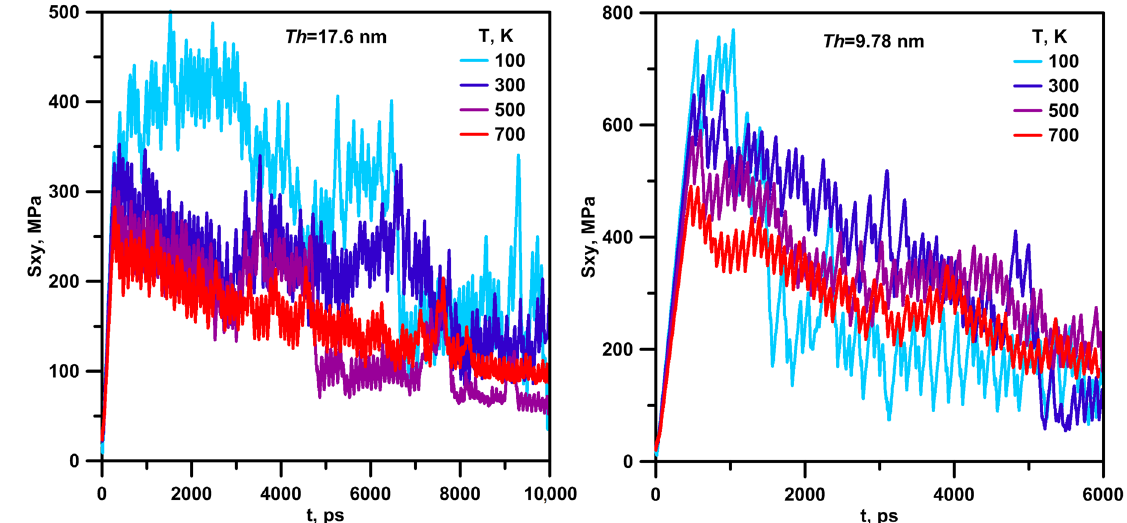
Figure 4. Time dependences of the average stress in systems containing θ ’ precipitate for various temperatures. Diameter of θ ’ precipitate is 5 nm, thicknesses of systems, equal to the inter-precipitate distance, are 9.87 and 17.6 nm, shear velocity is 3 m/s.